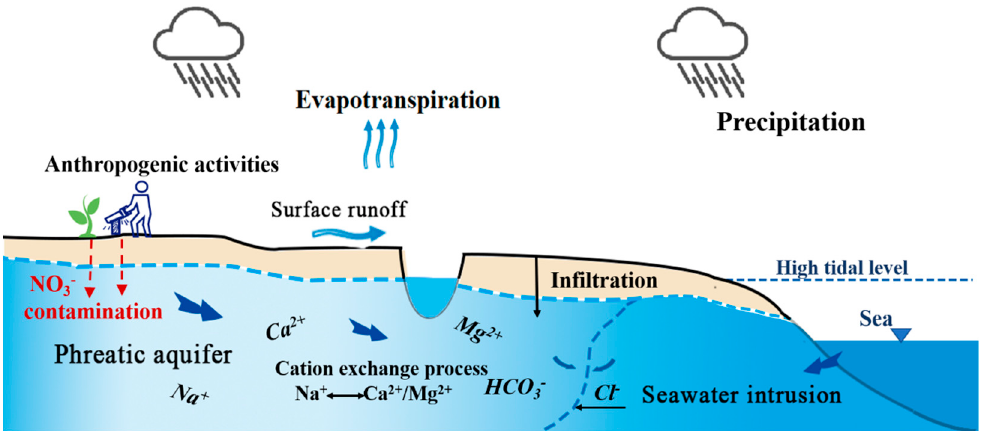
Figure 9. Conceptual model of the main hydrochemical evolution mechanisms recognized in the study area.